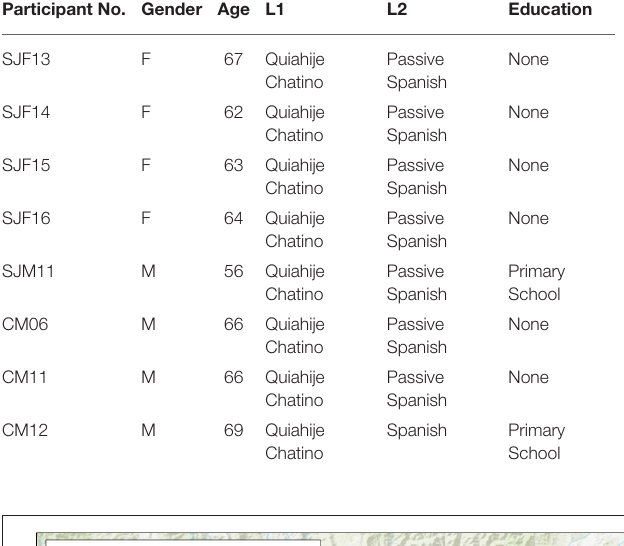
TABLE 2 | Participant information.